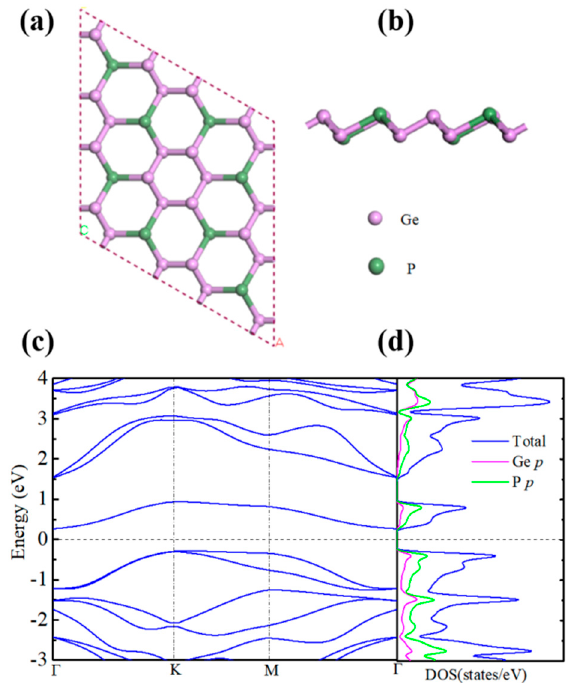
Figure 1. The top ( a ) and side ( b ) views of the crystal structure and the band structure ( c ) and atomic orbit-resolved density of states ( d ) for monolayer GeP 3 . The pink and green balls represent the Ge and P atoms, respectively.